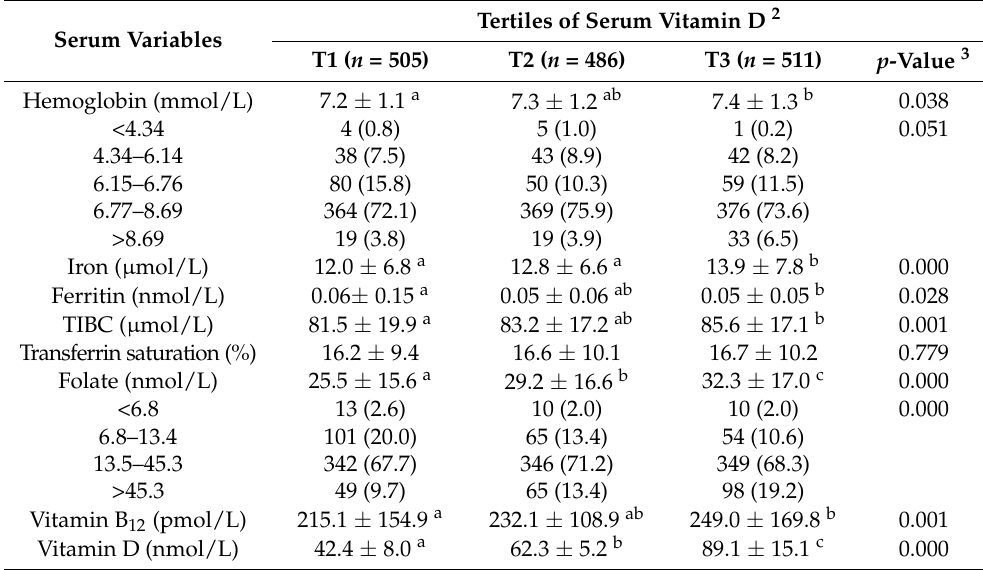
Table 2. Biochemical characteristics of the women across the tertiles of serum vitamin D ( n = 1502) 1 . Serum